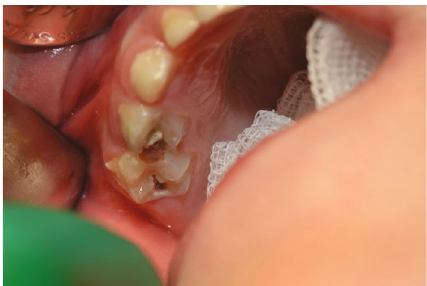
Figure 1: Intraoral view of operative region. Even though the needle is visible on the radiograph, it is not possible to fi rmly locate it intraorally.